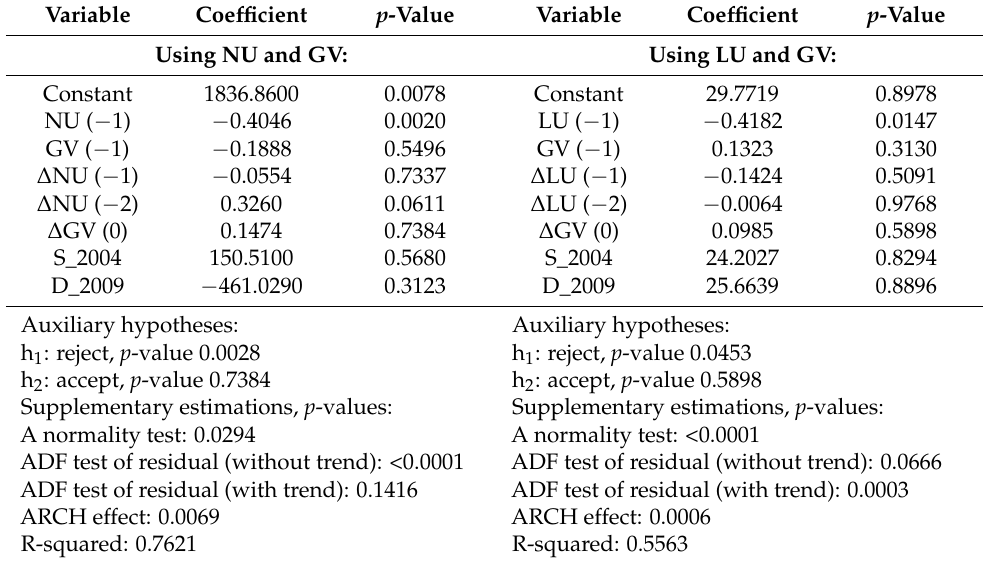
Table 5. Autoregressive distributed lag (ARDL) estimations for Lithuania. Variable